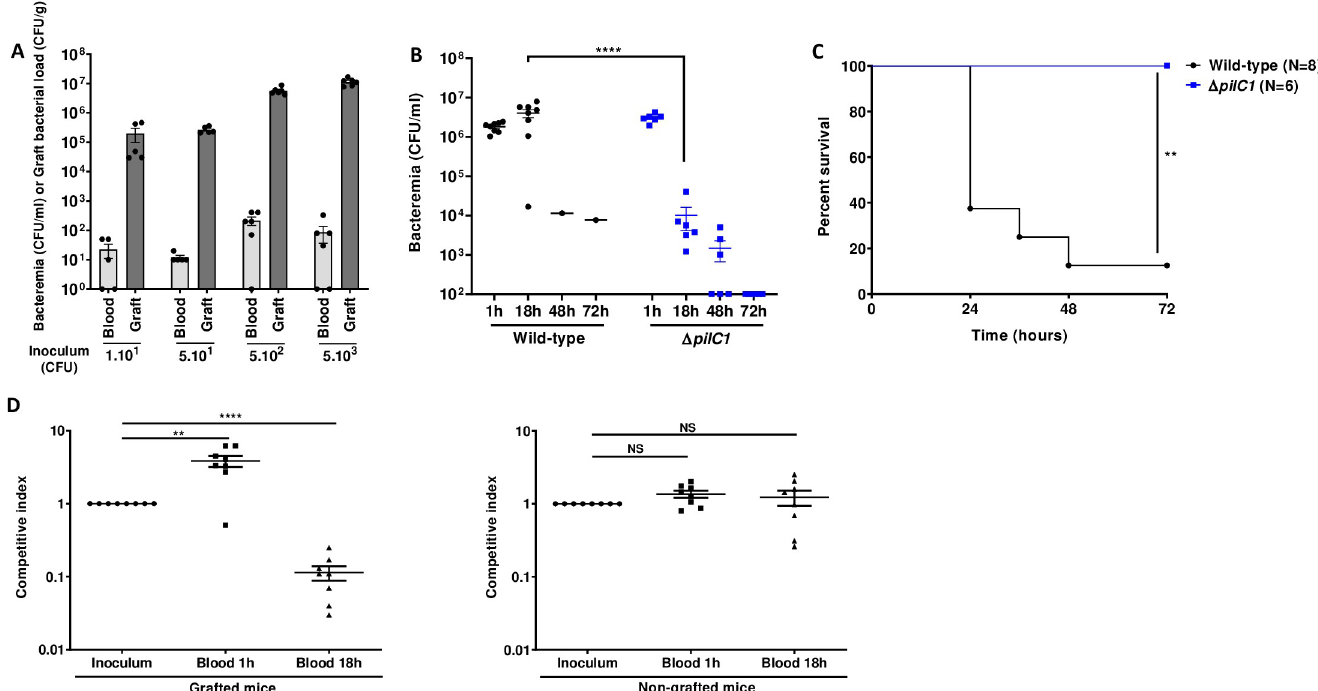
Fig 1. Human graft is a replicative niche for Neisseria meningitidis allowing sustained bacteremia. (A) Grafted mice were infected with a rising range of inocula: 1x10 1 , 5x10 1 , 5x10 2 , and 5x10 3 CFU of WT N . meningitidis . Bacteremia and graft bacterial load were assessed at the time of sacrifice 18 h PI by quantitative culture. Bacterial counts are expressed in CFU/ml for blood and in CFU/g for graft. Two independent experiments, n = 5 or 6 mice per group, grafted with skin obtained from two different donors. Bars represent mean ± SEM. (B) Grafted mice were infected intravenously with 5x10 6 CFU of WT N . meningitidis and its isogenic piliated non- adhesive mutant Δ pilC1 . Bacteremia was measured at 1, 18, 48 and 72 h by culturing serial dilutions of blood samples on agar plates. Two independent experiments, n = 6 or 8 mice per group. Bars represent mean ± SEM, ���� p < 0.0001, one-way ANOVA followed by multiple comparison test. (C) Kaplan-Meier plot showing the survival of infected grafted mice shown in panel B. Mice survival was assessed each day during 72 h. Two independent experiments, �� p < 0.01, two-sided log-rank Mantel-Cox analysis. (D) A competition assay between WT N . meningitidis and its isogenic piliated non-adhesive mutant Δ pilC1 was performed on both grafted (left panel) and non-grafted (right panel) mice. Mice were infected IV with an inoculum of 1x10 7 CFU total (a mixture of 5x10 6 CFU of WT and 5x10 6 CFU of Δ pilC1 mutant). Competitive index, defined as the mutant/WT ratio within the output sample, divided by the corresponding ratio in the inoculum, was measured in the blood of mice at 1 h and 18 h PI by tail vein blood puncture. Two independent experiments, n = 8 mice per group. Bars represent mean ± SEM, NS p > 0.05; �� p < 0.01; ���� p < 0.0001, one-way ANOVA followed by multiple comparison test.